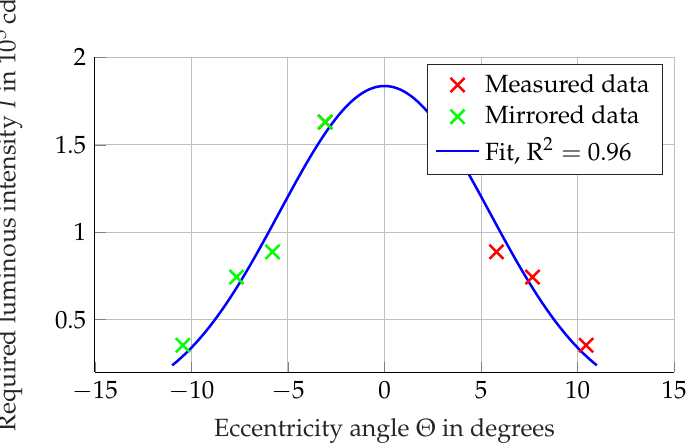
Figure 4. Required light intensity I for a detection object at a distance of about 90m as a function of the eccentricity angle Θ according to the field investigations of Schneider [34]; with increasing eccentricity angle, the required light intensity decreases, and the coefficient of determination of the correlation is R 2 = 0.96